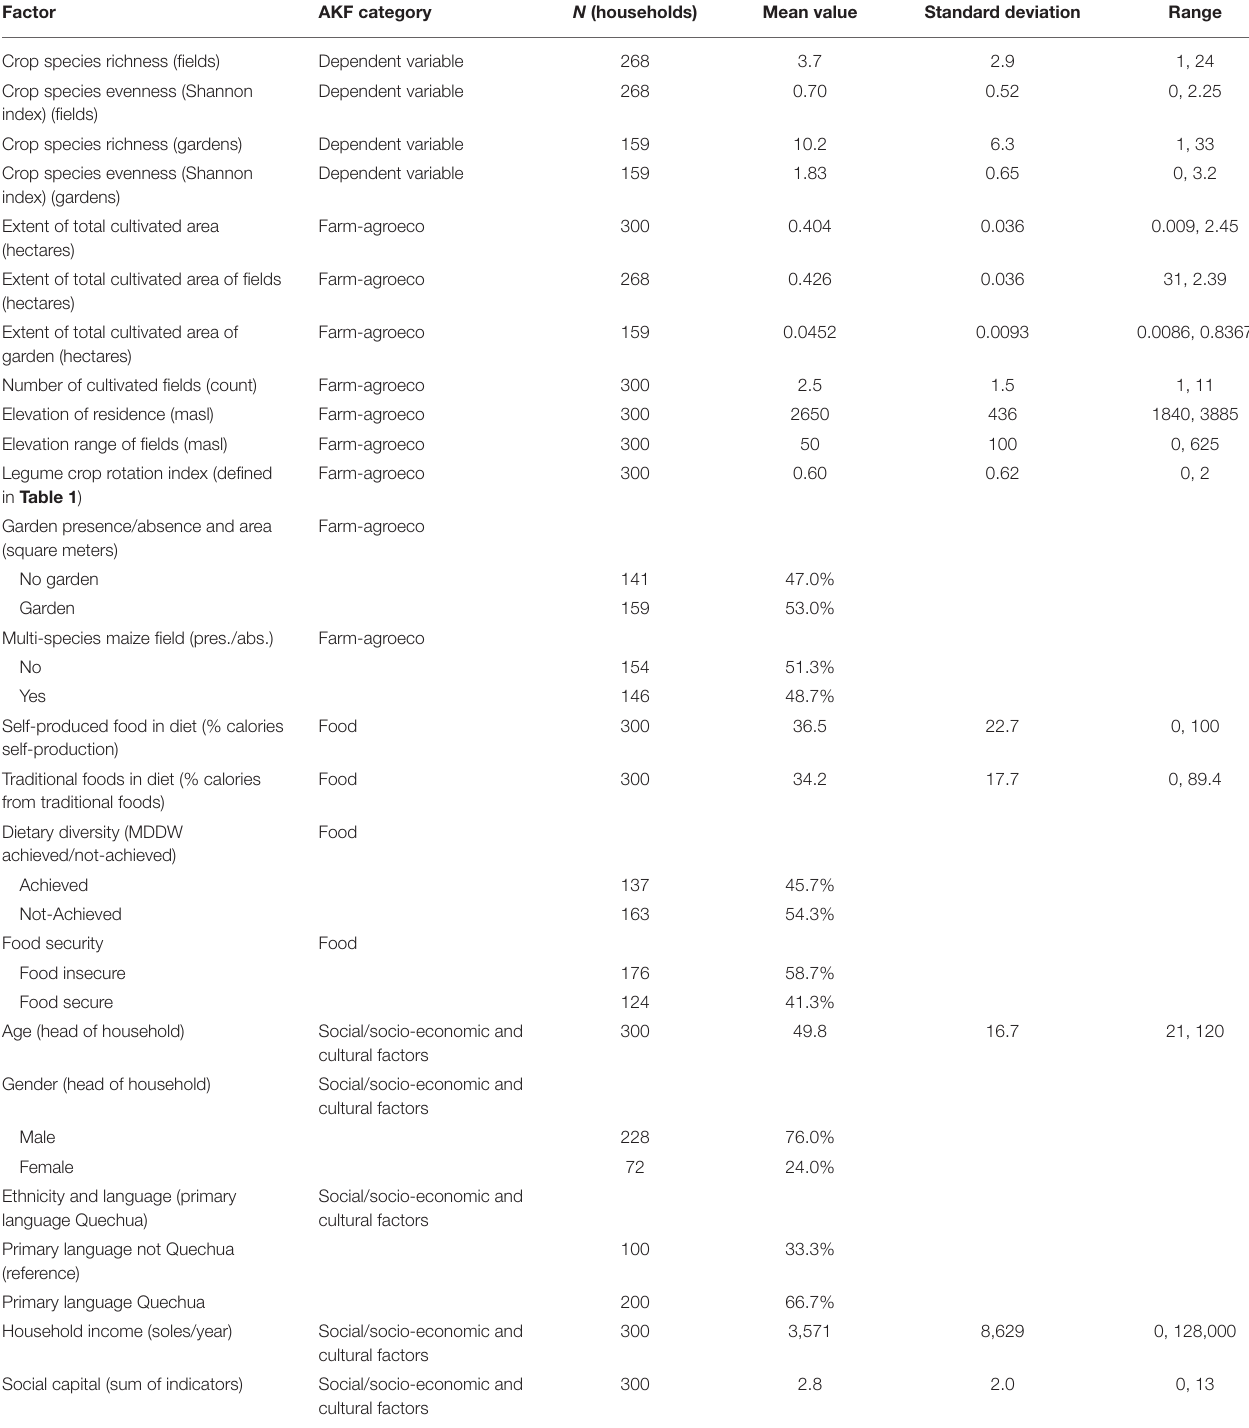
TABLE 2 | Estimations of the social-ecological and political-ecological factors of the Agrobiodiversity Knowledge Framework (AGK) in the sample utilized for the regression analysis of fields. Factor AKF category N (households) Mean value Standard deviation Range Crop species richness